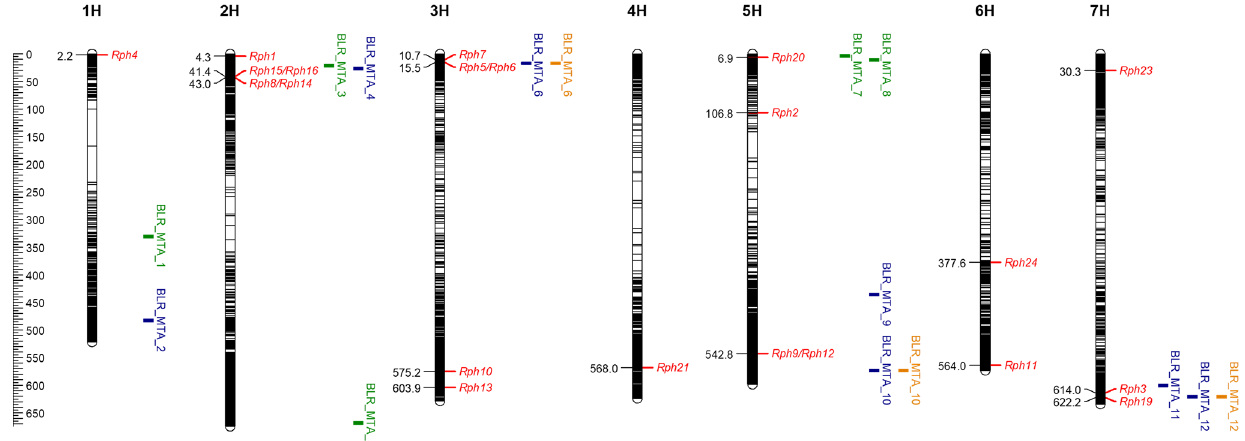
Figure 2. Visualization of known Rph genes in red (position based on BLAST search of published linked markers). QTLs identified at reading 1, 2019 represented in green, QTLs identified at reading 2, 2019 represented in blue and QTLs identified at the 2021 reading represented in orange, visualized on Morex v2 2019. QTLs were based on a single marker significantly associated at the 0.1% ( − log10p > 3) level; a confidence interval of 2.5 Mbp was used for visualization purposes. Marker–trait associations (MTAs) represent genomic regions identified using genome-wide association mapping of breeding lines (high- and low-input) and landraces imported as part of the CAIGE program in 2018 and assessed in the field (Cobbitty NSW) at adult-plant stage in 2019 and 2021. Table 1. Summary of the marker–trait associations (MTAs) detected at three time points (R1_2019, R2_2019 and 2021) at adult-plant stage in field.